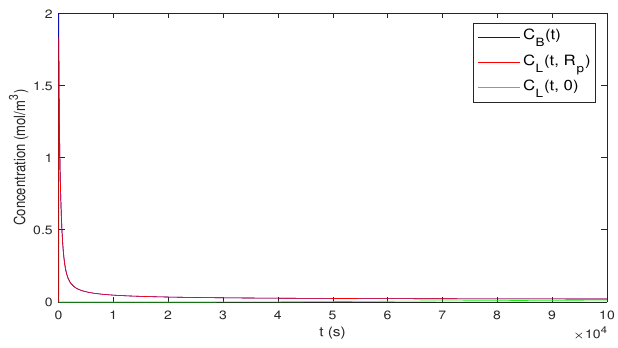
Figure 3. Bulk concentration, concentration of the solute in the liquid on the surface of the particle and concentration of the solute in the liquid at the center of the particle for the data reported in [13].